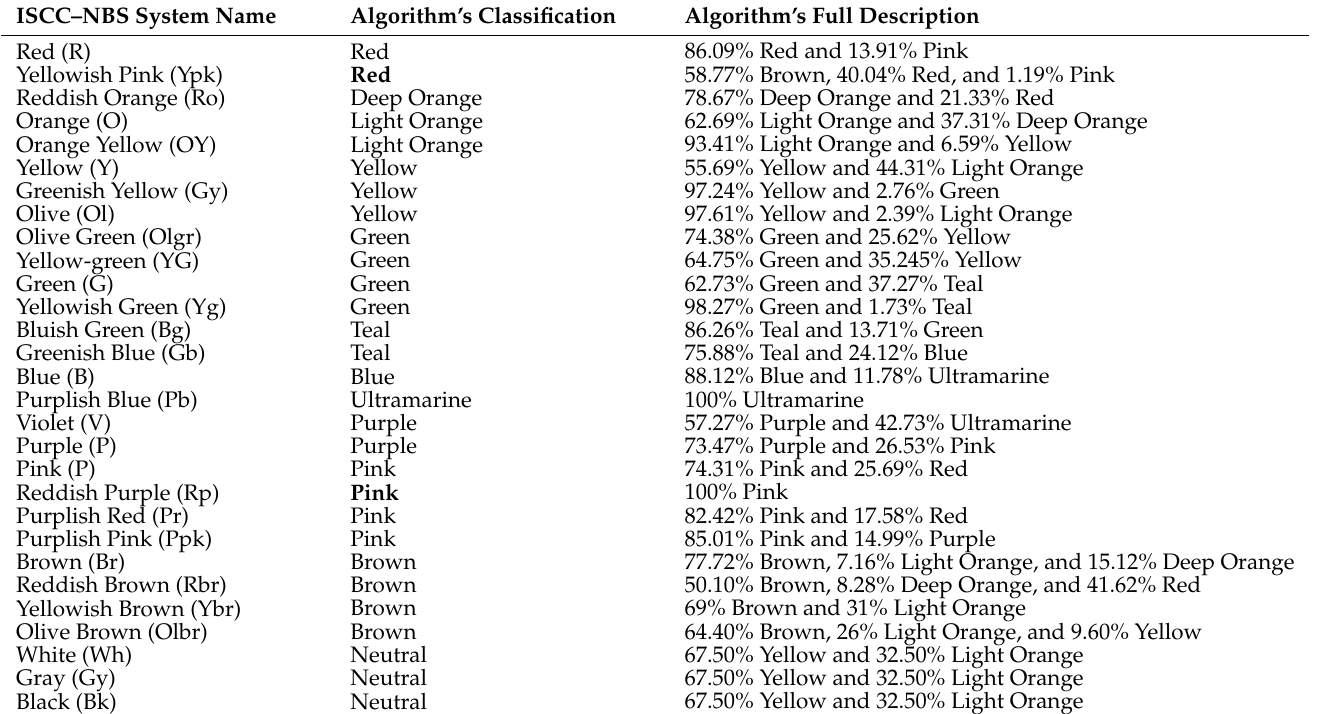
Table 1. Full analysis of each shade of the official ISCC–NBS color classification Level